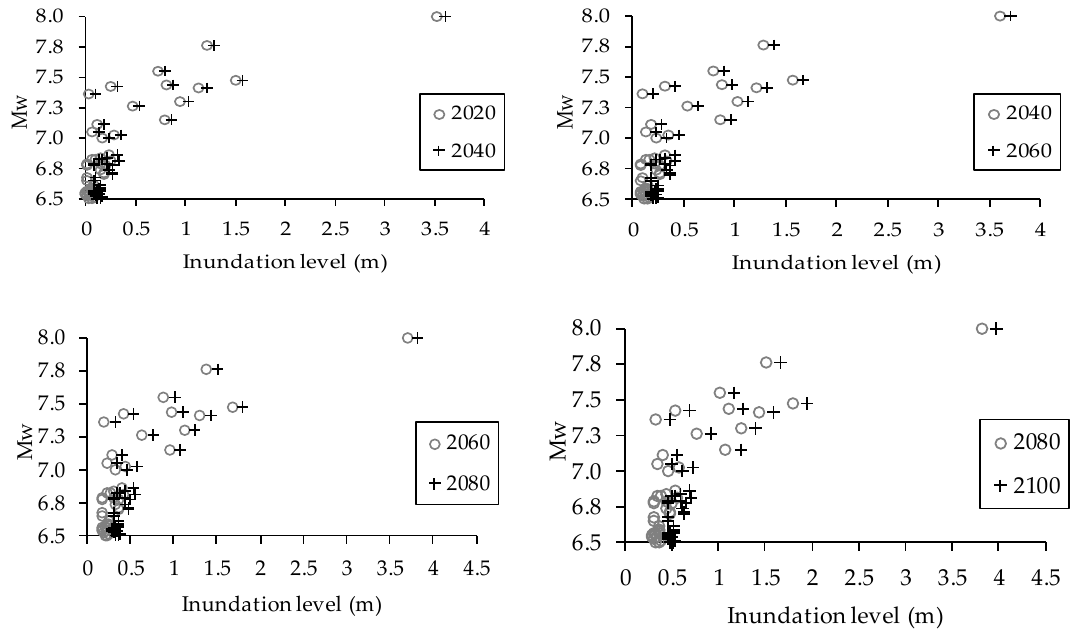
6.56.87.07.37.57.88.0 Figure 7. Comparison of the calculated inundation levels with the previous time period for Fethiye City Center, Turkey.